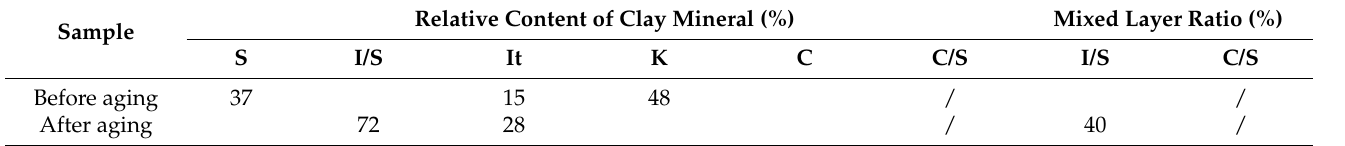
Table 5. Clay content before and after aging